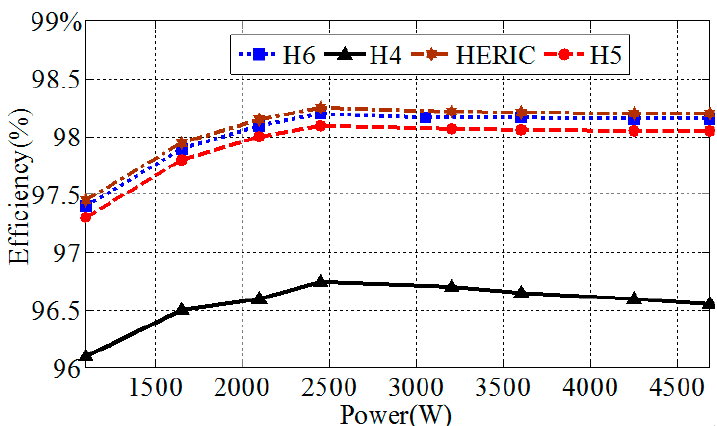
Figure 24. The efficiency of inverters.